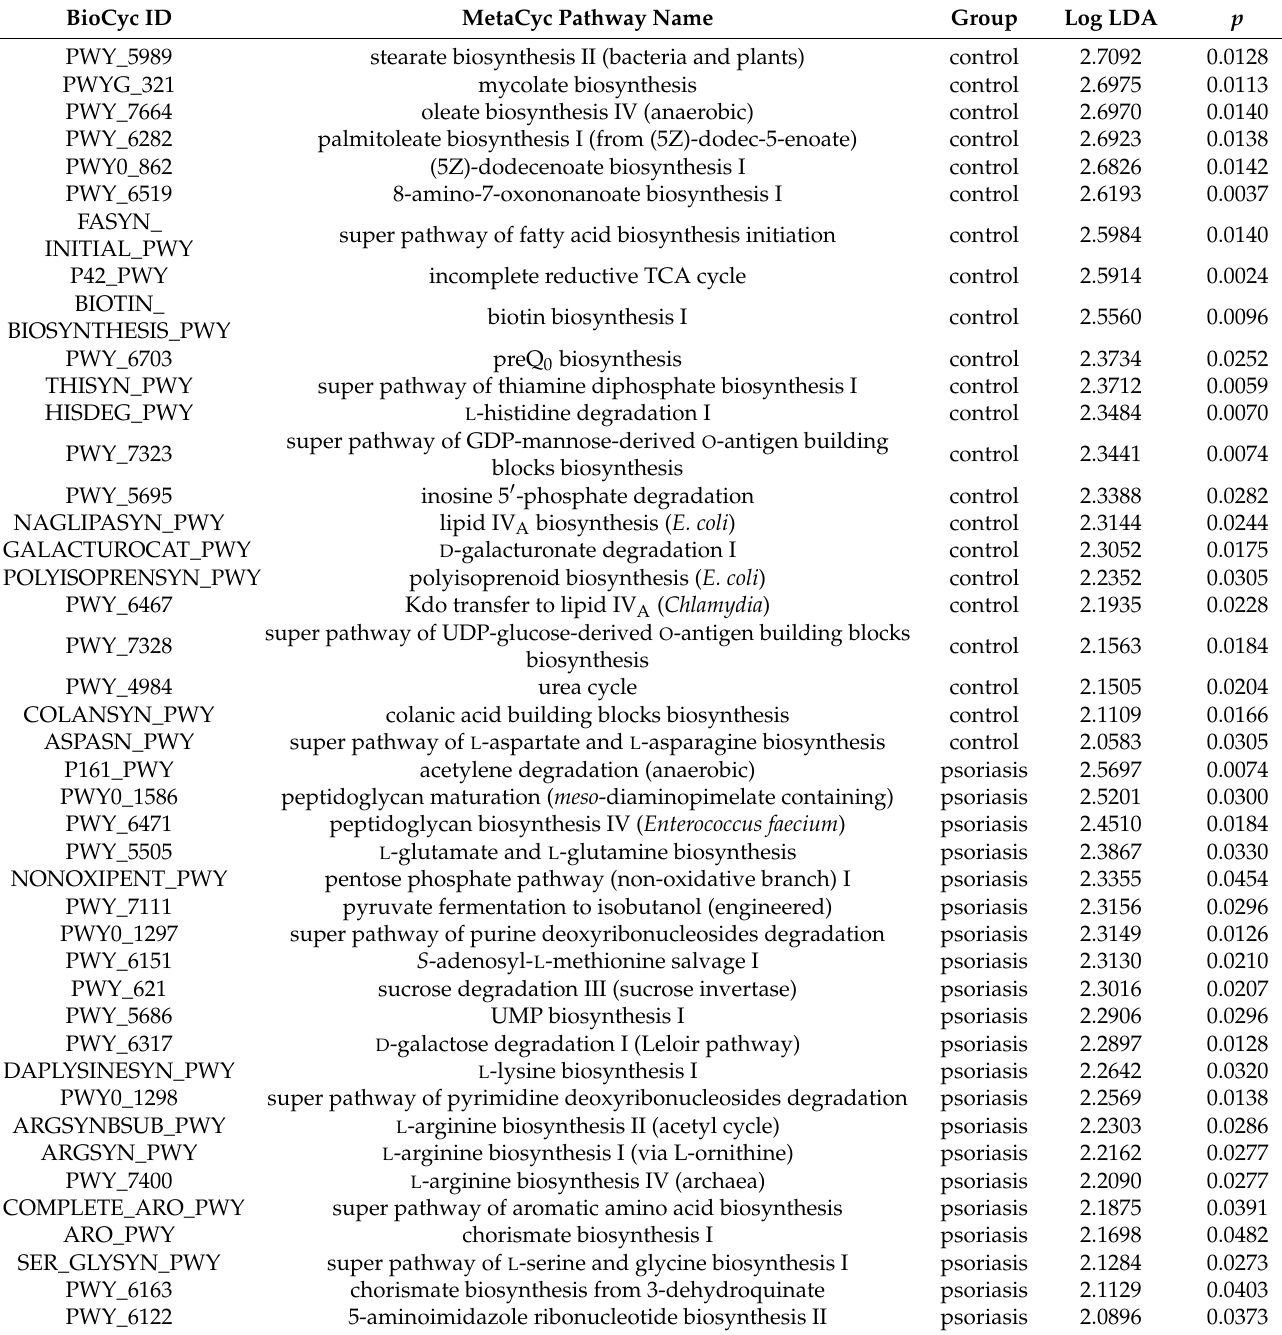
Table 5. Differentially abundant MetaCyc pathways and its corresponding LDA score and p value inferred by PICRUSt2 and